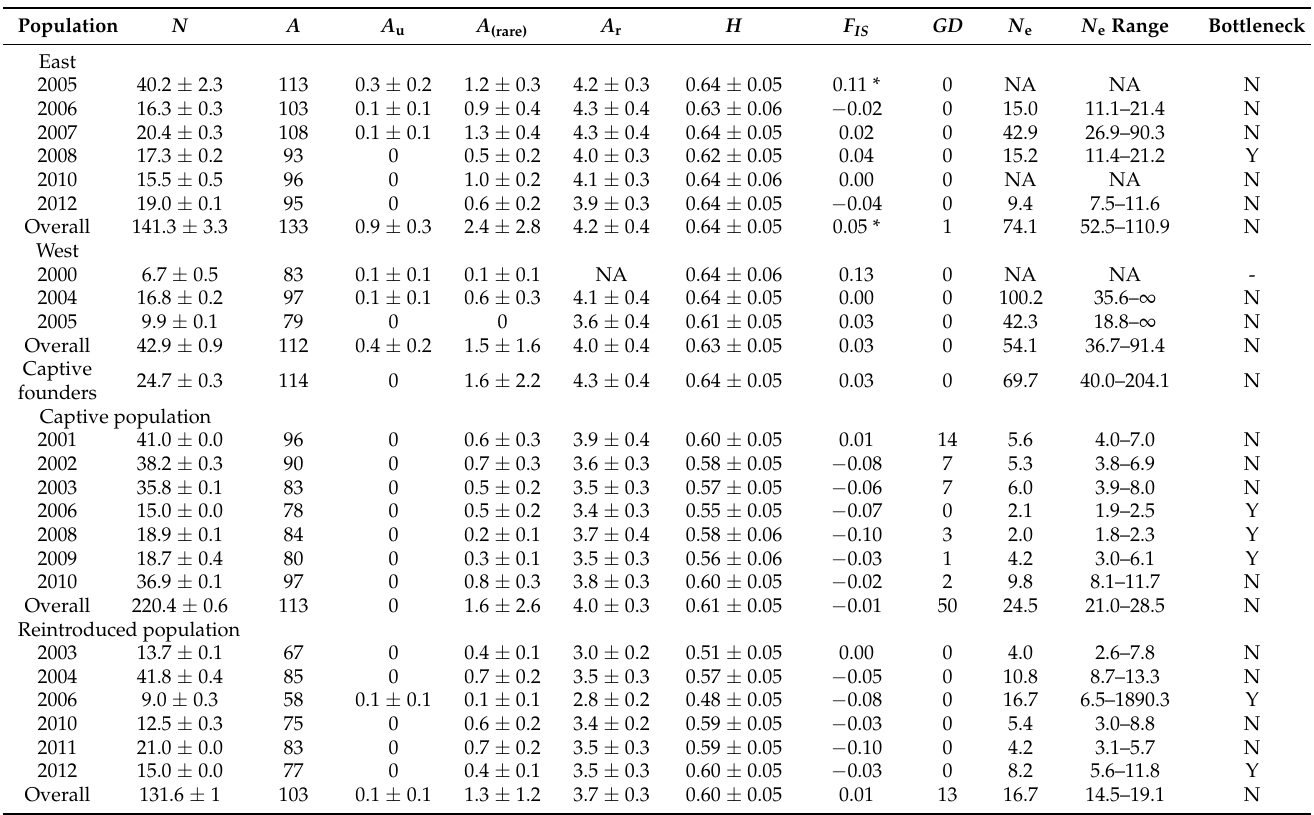
Table 3. Estimates of genetic variation over 20 microsatellite loci within the source, captive and reintroduced Parantechinus apicalis populations. N is an average sample size per locus. A is the total number of alleles. A u is an average of unique alleles. A (rare) is an average number of rare alleles (frequency < 5%). A r is allelic richness. H is gene diversity. F IS is inbreeding coefficient. GD is genotypic disequilibrium. N e is an effective population size. Standard errors are given after mean values. Asterisks represent F IS values significantly different to zero at p <